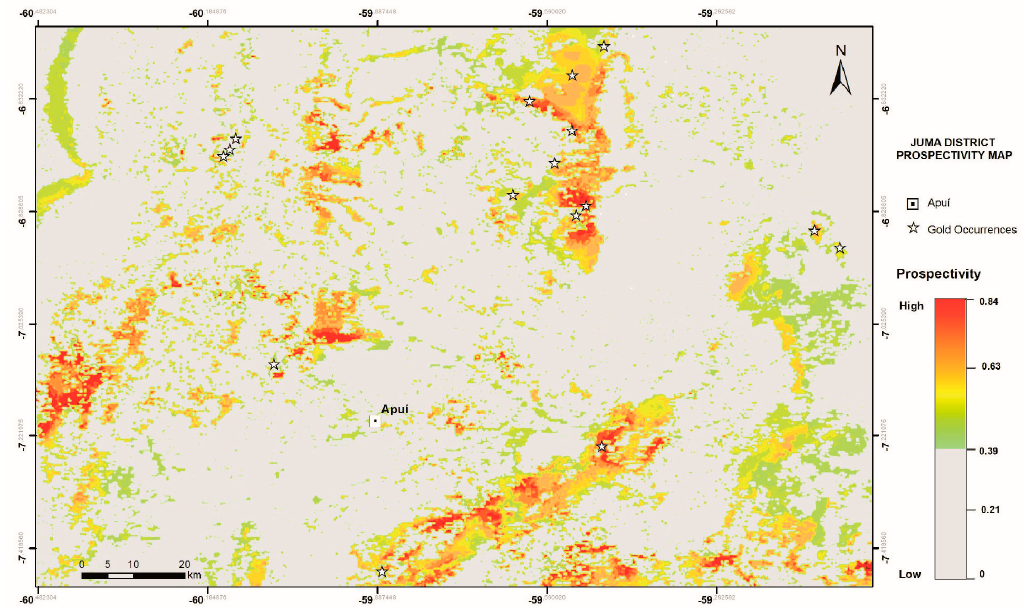
Figure 7. Juma District mineral prospectivity map and known gold occurrences. Regions with similar potential to host magmatic–hydrothermal gold are delimited by the prospectivity scores (0–0.84). The higher values correspond to the most favorable areas (warm colors). The areas corresponding to medium-lower prospectivity scores (0–0.39) are gray.